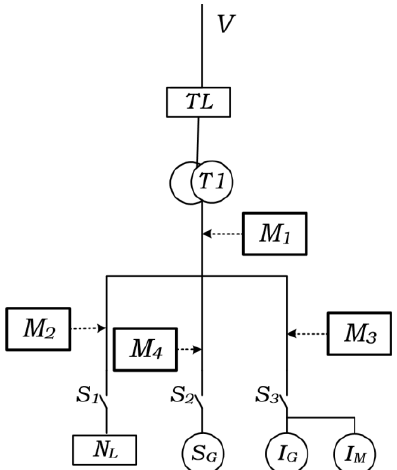
Fig. 6. Interconnected electrical power system - IEPS for Case Study